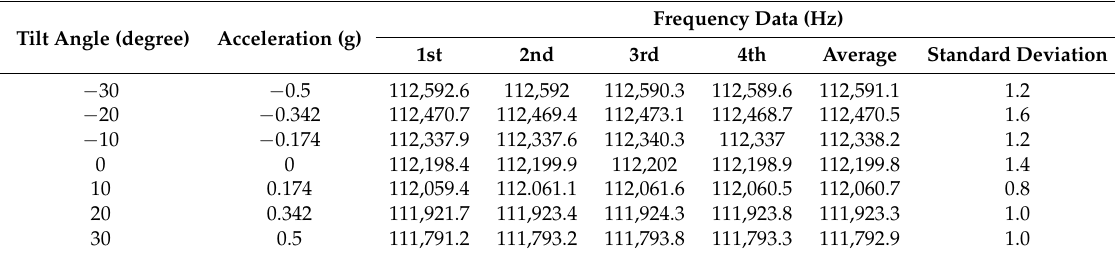
Table 2. Output of DETF B at each position.